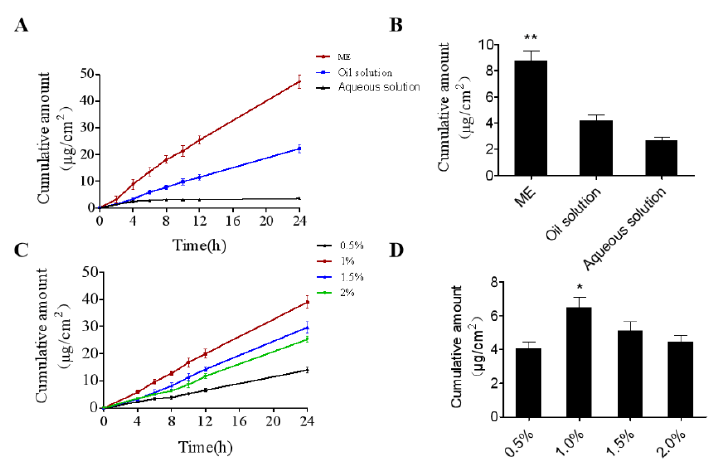
Figure 5. In vitro transdermal permeation profiles. ( A ) The vitro transdermal release curve of IR in different carriers. ( B ) The retention amount of IR in the skin of different carriers. ( C ) The vitro transdermal release curve of IR in different substrate concentrations. ( D ) The retention amount of IR in the skin of different substrate concentrations. The results were expressed as the mean ± SEM. The comparisons between groups were performed using one-way ANOVA (Tukey’s multiple comparisons test). ** p < 0.01 vs. Oil solution and Aq solution; * p < 0.05 vs. 0.5%, 1.5% and 2% gel ( n = 3). Table 1. In vitro permeation parameters of IR from different formulations through mice back skin ( n = 3).